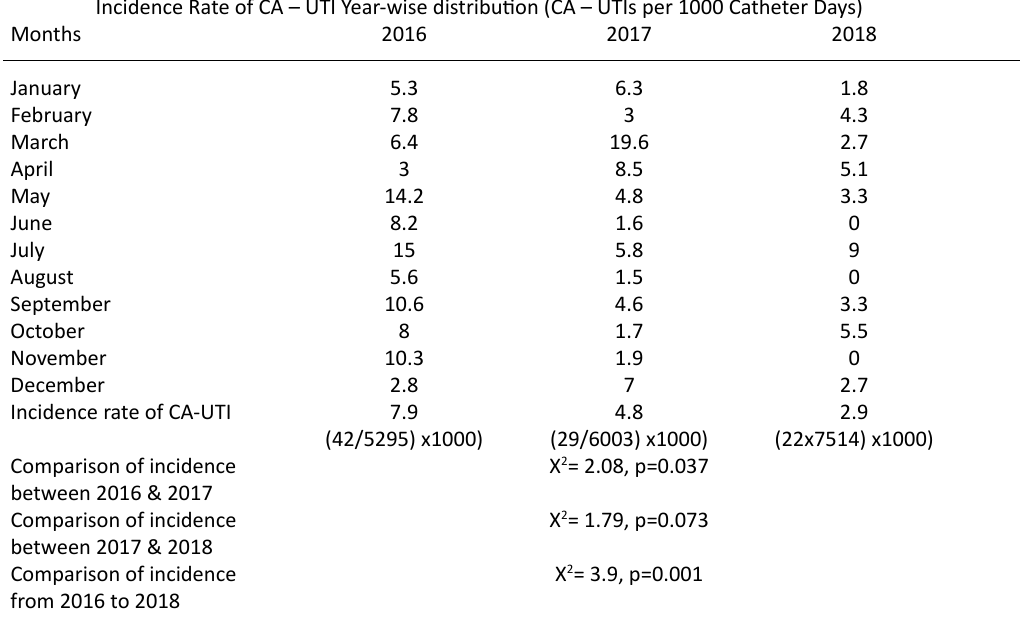
Table 1. Incidence rate of CA- UTI year-wise